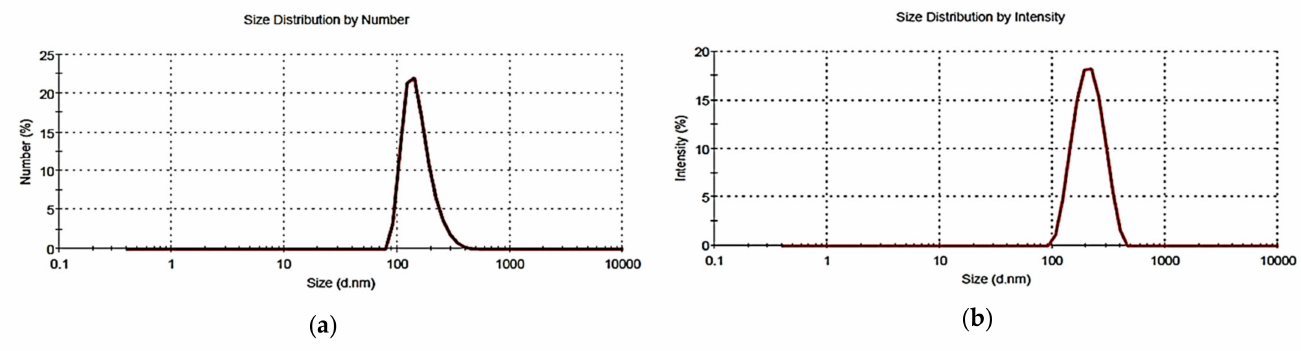
Figure 5. Representative particle size distribution of G5-PDK reported by number ( a ) and by intensity ( b